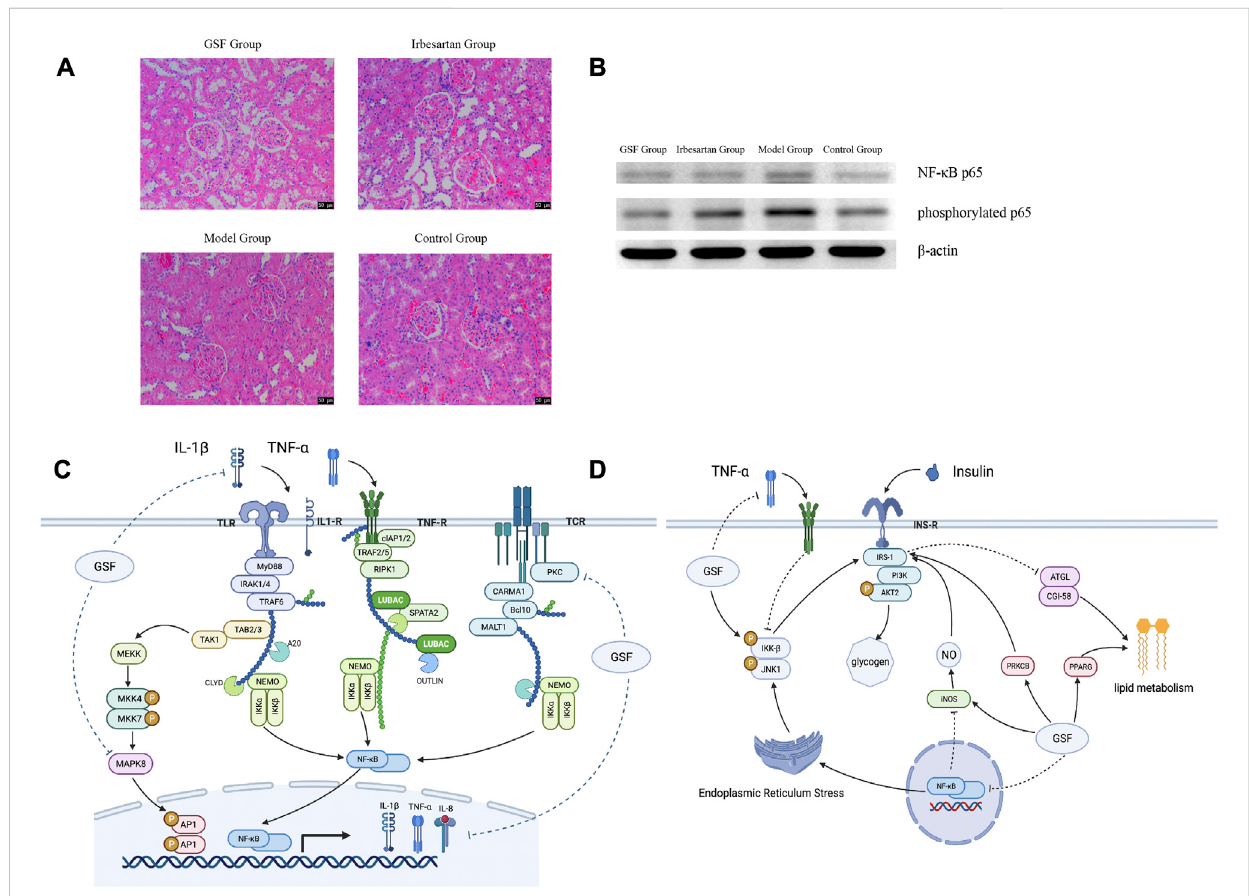
FIGURE 5 MechanismofactionofGSF. (A) HEstainingofkidneysat×200magni fi cation. (B) ExpressionofNF- κ Bp65inthekidney. (C) GSFregulatestheNF- κ B signaling pathway; it can interfere with the production of the IKK complex in the NF- κ B pathway and inhibit NF- κ B protein phosphorylation by regulating TNF- α , IL-1 β , and PKC. At the same time, GSF can also reduce AP1 phosphorylation and reduce the production of in fl ammatory factors by affecting MAPK8. (D) GSF regulates thedownstreamin fl ammatoryreaction,regulates theNF- κ Bpathway, reducesthesecretion ofin fl ammatoryfactors,and improves IRS-1 activity, insulin resistance, and lipid metabolism directly or indirectly by inhibiting the IKK- β